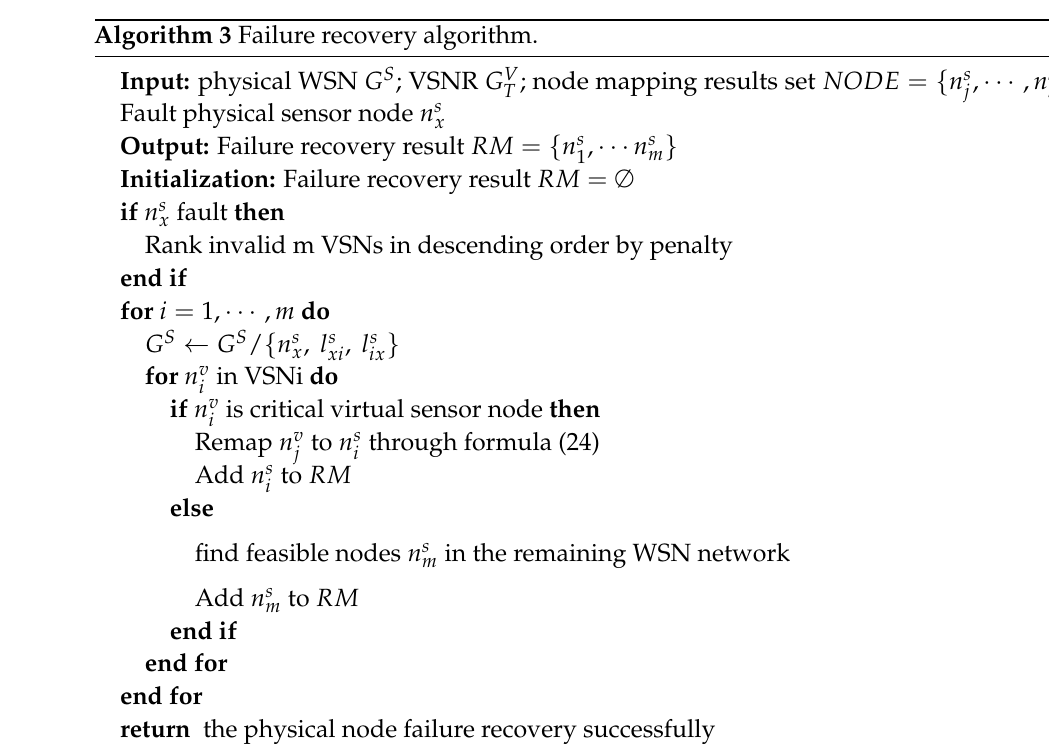
Algorithm 3 Failure recovery